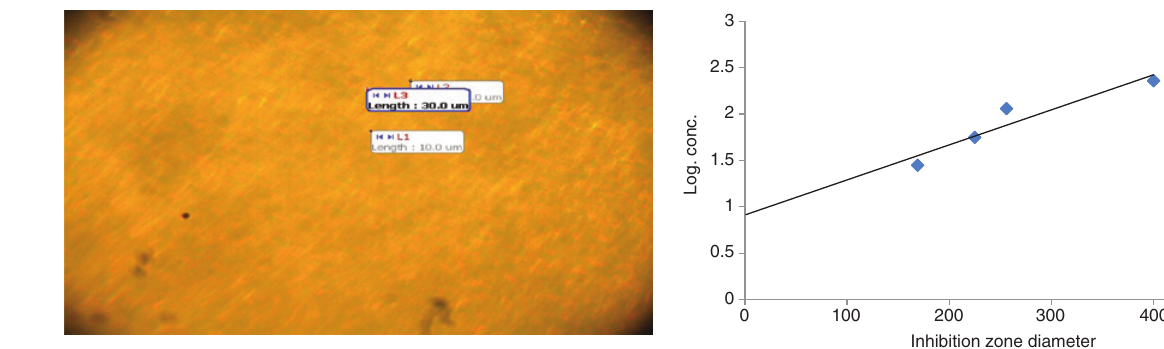
Figure 4: Graph of the log concentration and IZD showing the point of MIC (in mg/ml) of AgNeemnano solution against Fusarium moniliforme.